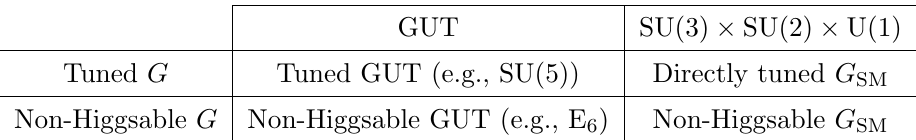
Table 1 . Di(cid:11)erent approaches to realizing the standard model in F-theory can involve combining either tuning or non-Higgsable structure with either uni(cid:12)cation (GUTs) or non-uni(cid:12)ed standard model gauge group